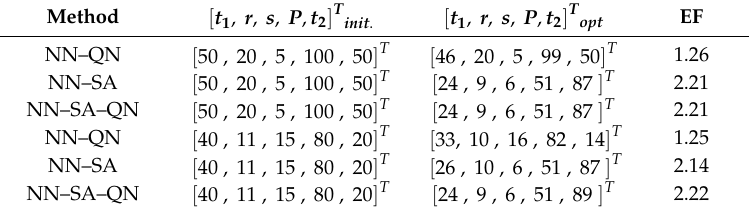
Table 2. Optimized geometry of plasmonic OPV and corresponding enhancement factor (EF) values.